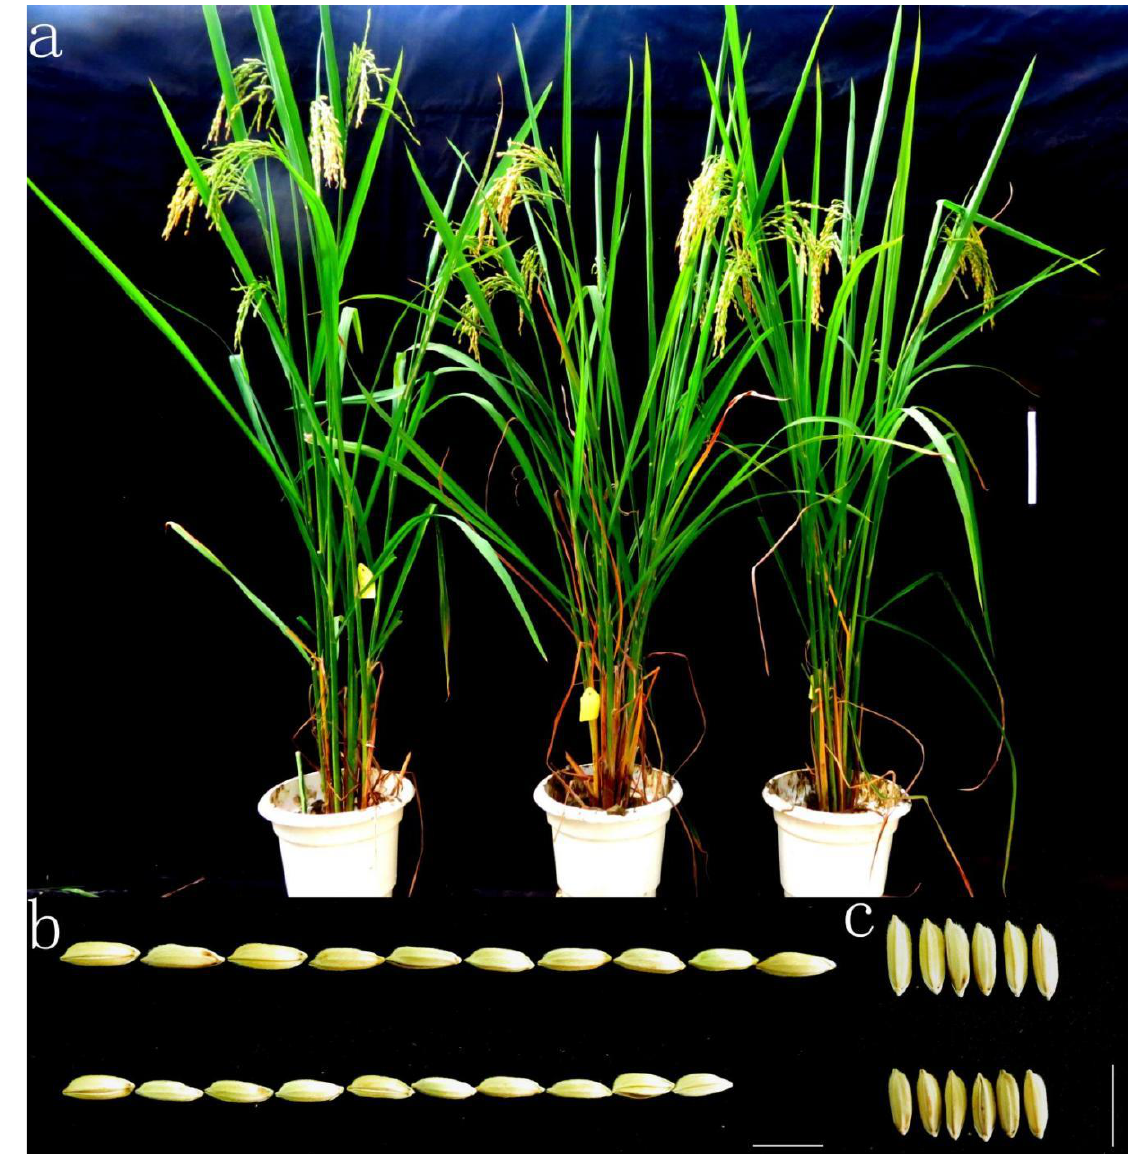
Figure 5. Plant appearance and grain shape of the pyramid line. ( a ) Plant appearance, from left to right: S24, D7 (S24/S29), HJX74. Bar = 15cm. ( b ) Grain length for HJX74 ( up ) and S24 ( down ). Bar =